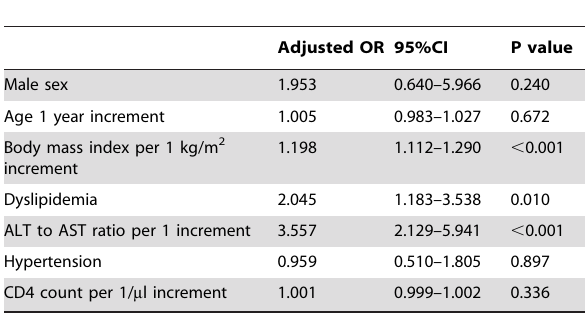
Table 4. Multivariate analysis of independent